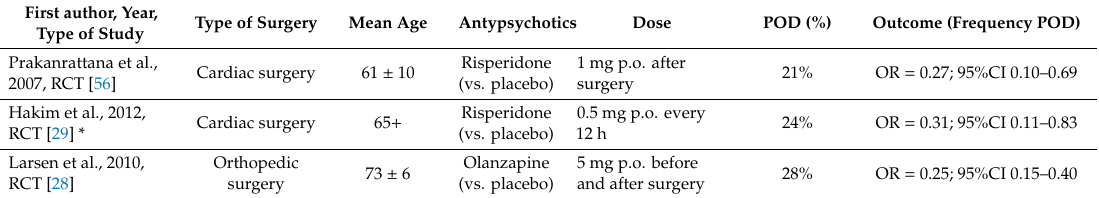
Table 4. Studies evaluating the e ff ectiveness of atypical neuroleptics in the prevention of